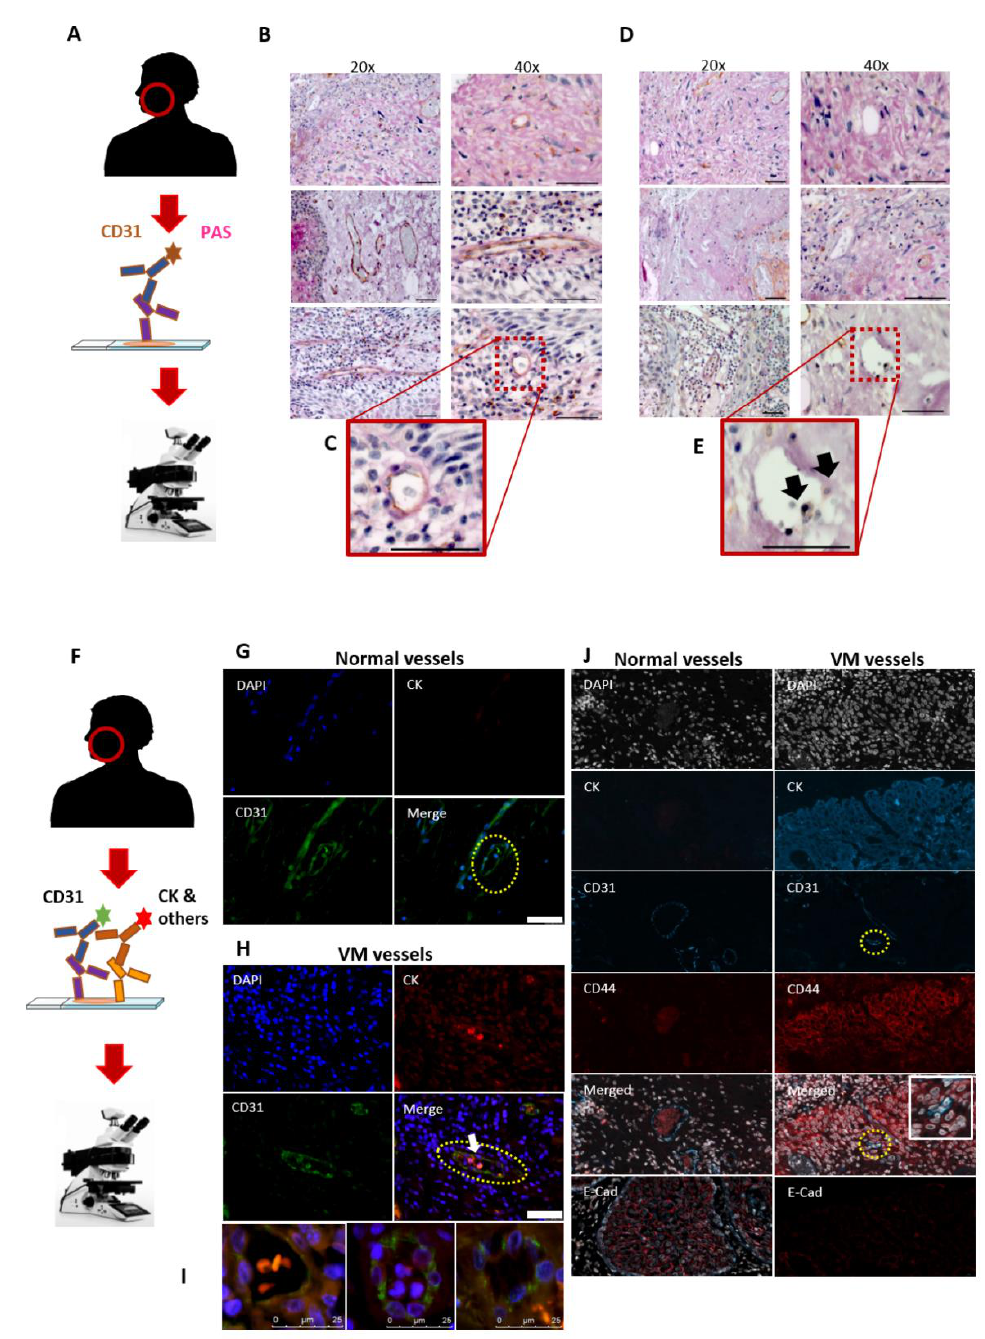
Figure 1. Identification of vascular mimicry (VM) in tumour tissues. ( A ) Representative figures from tumour sections ( n = 30) obtained from patients with oral tongue squamous cell carcinoma (OTSCC) and stained using a combination of endothelial cell (EC) marker (CD31) and periodic acid–Schiff (PAS) staining. ( B,C ) Normal blood vessels express CD31 +ve /PAS +ve (brown/pink). Scale bar: 50 µ m ( D,E ) Additionally, some CD31 -ve /PAS +ve vessel-like structures (pink) were identified. However, identifying these structures was often demanding due to the presence of necrotic areas or a faint CD31 signal (black arrows). Scale bar: 50 µ m. ( F ) The double-labelled immunofluorescence assay was employed using a combination of CD31 and tumour cell marker (pan-cytokeratin, CK) to investigate the presence of mosaic vessels in HNSCC sections. ( G ) EC-lined blood vessels were easily distinguished in the peritumoral areas (dashed yellow line). Scale bar: 50 µ m ( H ) The intratumoral CD31 +ve /CK +ve mosaic vessels were also observed (dashed yellow line; white arrow). Scale bar: 50 µ